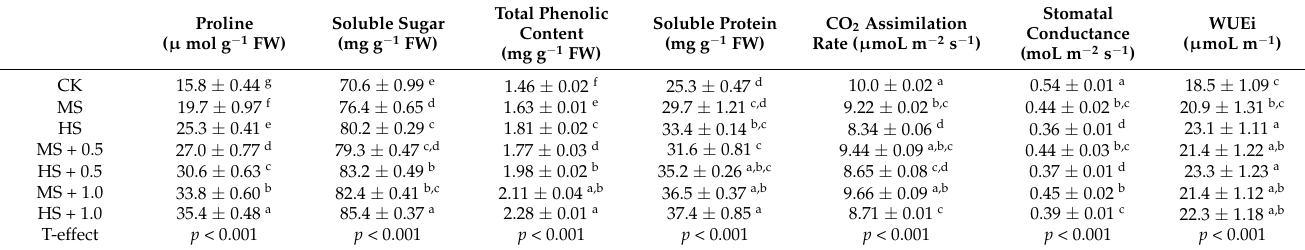
Table 2. Effect of soil water deficit and soil water deficit + foliar application of SA on proline, soluble sugar, total phenolic, soluble protein contents and CO 2 assimilation rate, stomatal conductance, and intrinsic water use efficiency in M. alba saplings. The small letters represent significant differences between the treatment means (T-effect) at p <